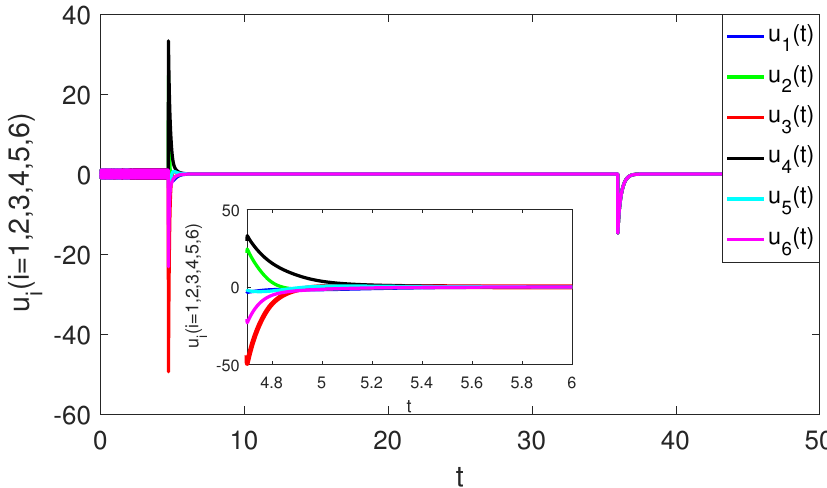
Figure 10. The evolution of control input u i ( t ) for i = 1,2, · · · ,6.